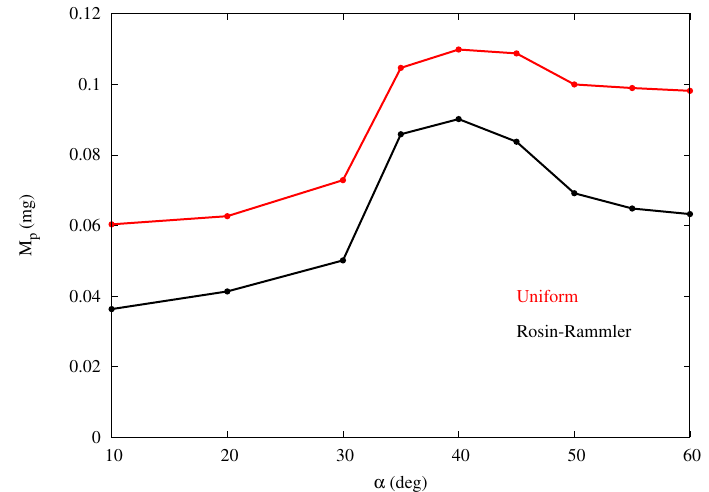
Figure 13. Droplet mass collection for varying body inclinations and fog droplets following the Rosin–Rammler distribution (runs G2–G10). The results obtained with uniform distribution (runs A2–A10) are also plotted for